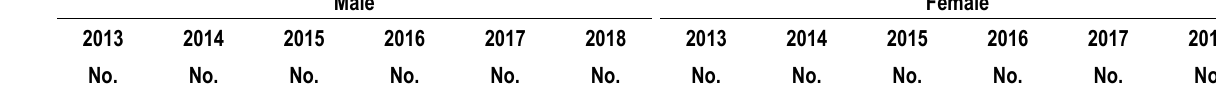
Table 12a. Stage 3 (AIDS) attributed to heterosexual contact, by selected characteristics, 2013–2018—United States (cont) Male